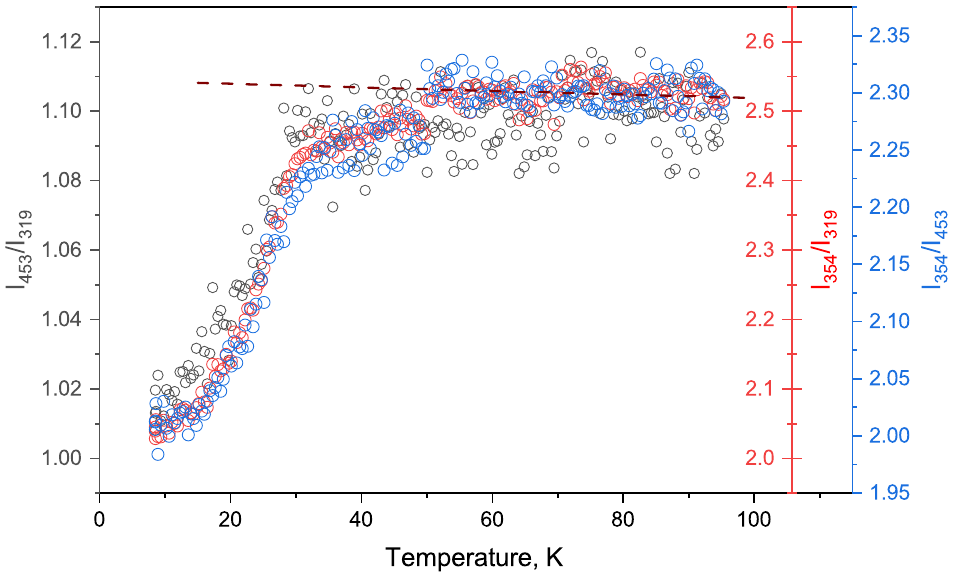
Figure 3. The relation of the integral intensities of several strongest hard modes. The crystal TbFe 2.46 Ga 0.54 (BO 3 ) 4 undergoes a structural phase transition at T c = 33